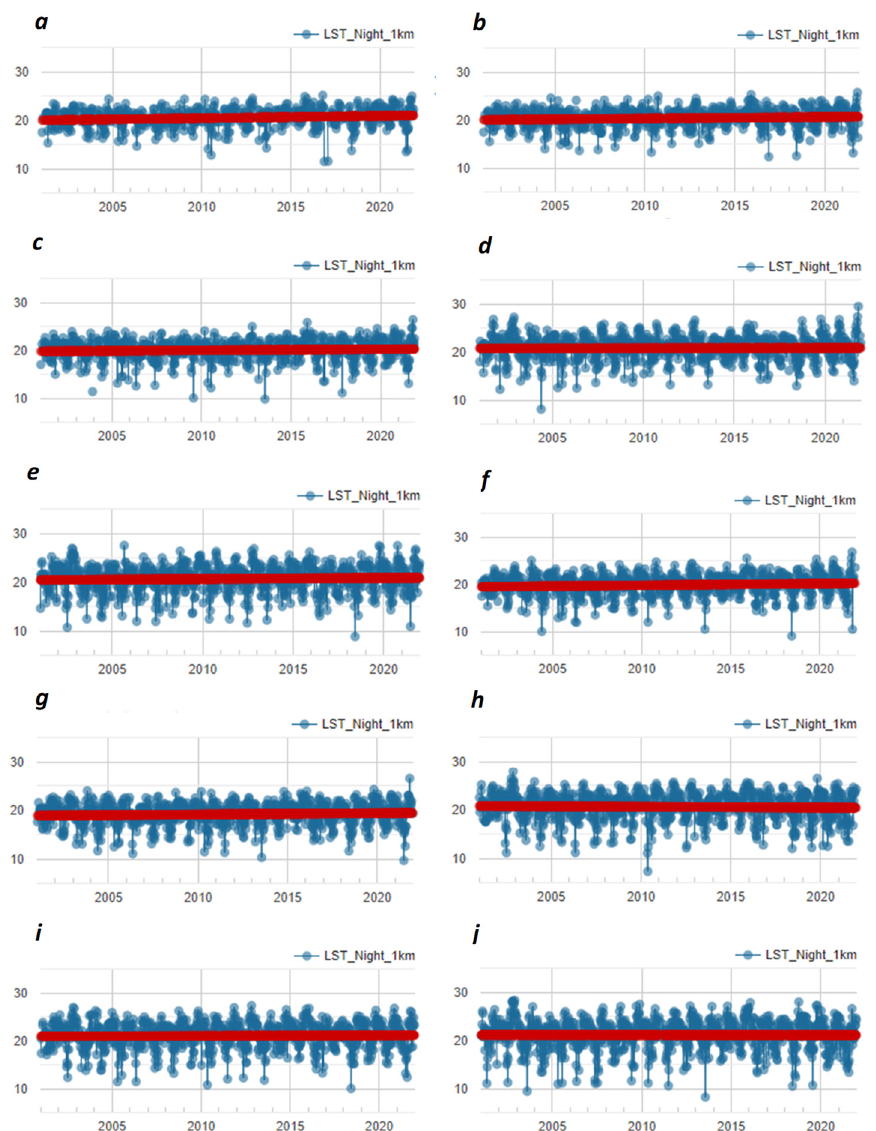
Figure 8. Trends in the time series of nighttime LST (°C) in forested and deforested areas in the Chiquitania region (2001–2021). The red line represents the trend line of the data points. Sites with intact forest: ( a ) Noel Kempff, ( b ) Bajo Paraguá, ( c ) Monteverde, ( d ) San Rafael, and ( e ) Tucabaca. Sites with deforestation: ( f ) San Ignacio, ( g ) Concepci ó n, ( h ) El Cerro/California, ( i ) Nueva Esperanza, and ( j ) Santa Ana/Buena Vista.